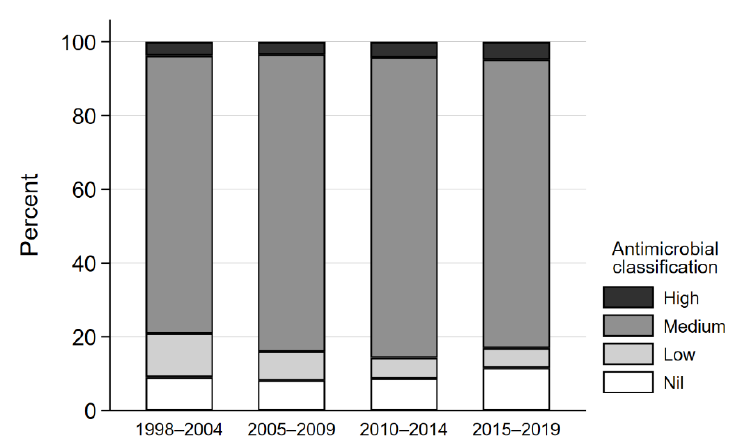
Figure 2. Antimicrobial importance prescribed per year category for the treatment of dogs presenting with dog-to-dog bite wounds from 1998–2004 to 2015–2018.